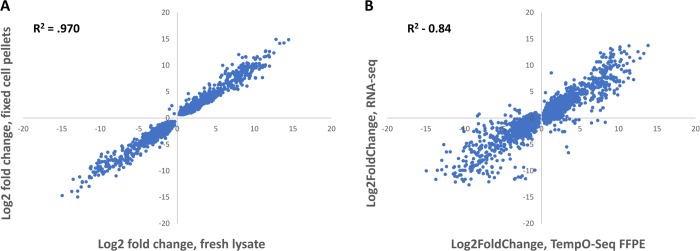
Correlation of gene log2 fold changes between fresh and fixed MCF-7 and MDA-MDA-MB-231 cells, and correlation of TempO-Seq with RNA-Seq.(A) Both MCF-7 and MDA-MB-231 cells from the same plate were split in half. One half was lysed directly and processed through the standard TempO-Seq human whole transcriptome assay (fresh lysate), and the other half was pelleted and fixed for FFPE embedding and sectioning to be processed through the TempO-Seq FFPE human whole transcriptome assay (fixed cell pellet). For each assay, differential expression was calculated between the two cell types. Log2 fold changes were then plotted for each assay to determine correlation of differential expression. (B) RNA-Seq was performed on RNA purified from fresh MCF-7 and MDA-MB-231 cells. TempO-Seq FFPE assay was performed on FFPE cell pellets produced from the same cell types. DESeq2 was used to determine statistically significant (padj <0.05) log2 fold changes between the different cell types and plotted to derive correlation of differential gene expression between the two methods.